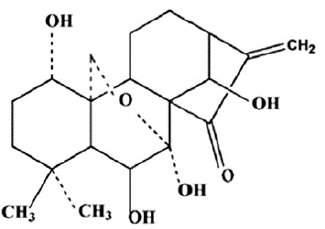
Figure 1. The chemical structure of